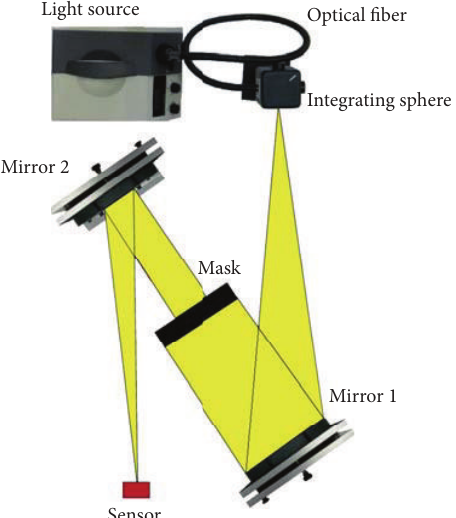
Figure 13: Practical realization of configuration L2 (for large